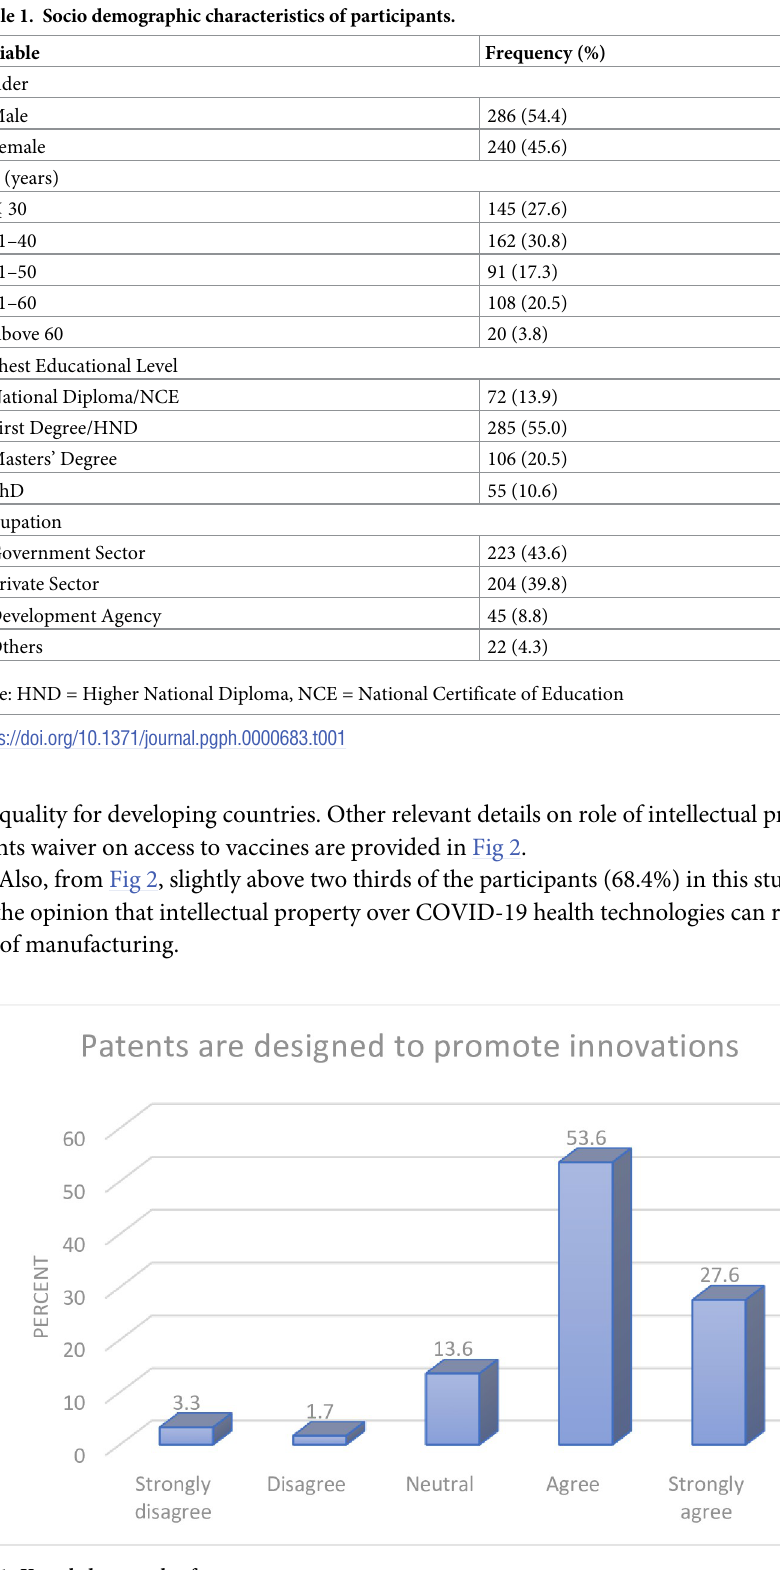
Fig 1. Knowledge on role of